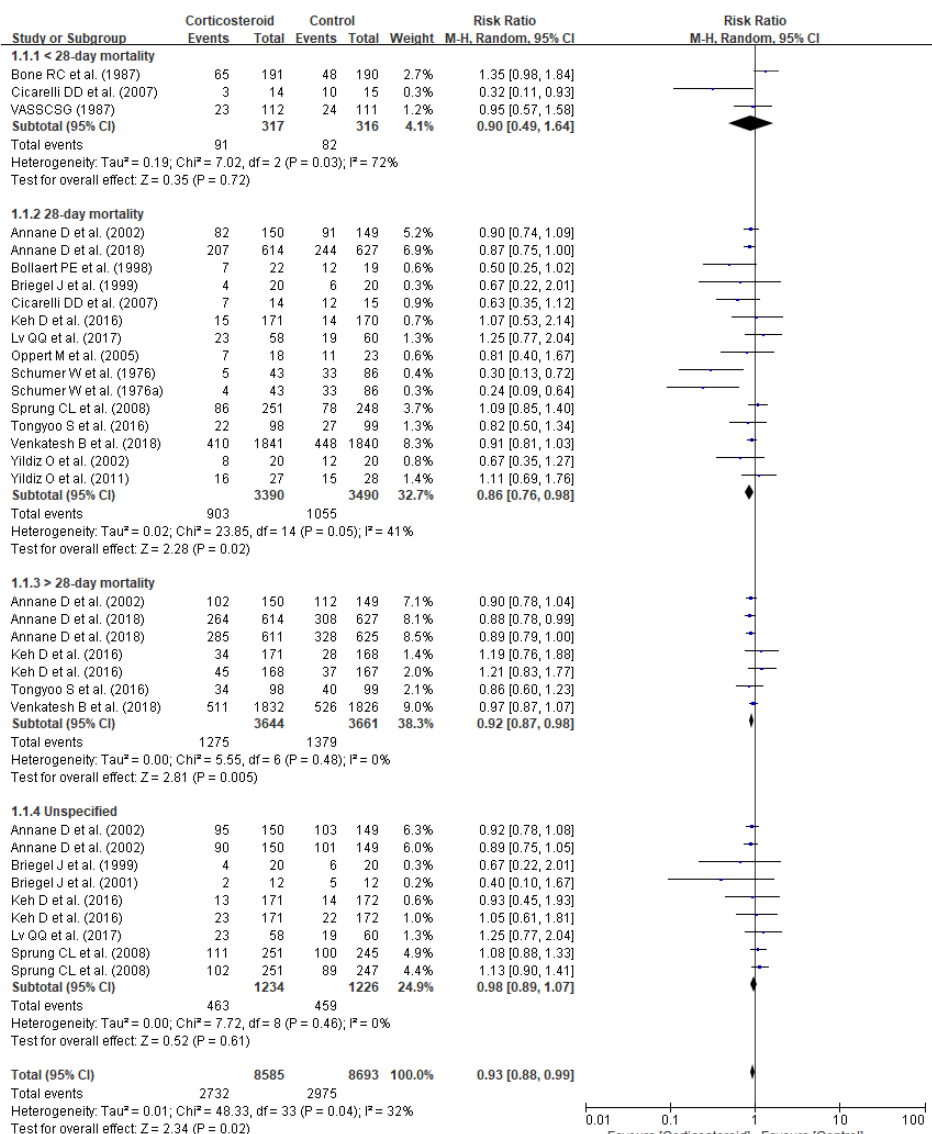
Figure 2. Forest plot of corticosteroid impact on mortality.